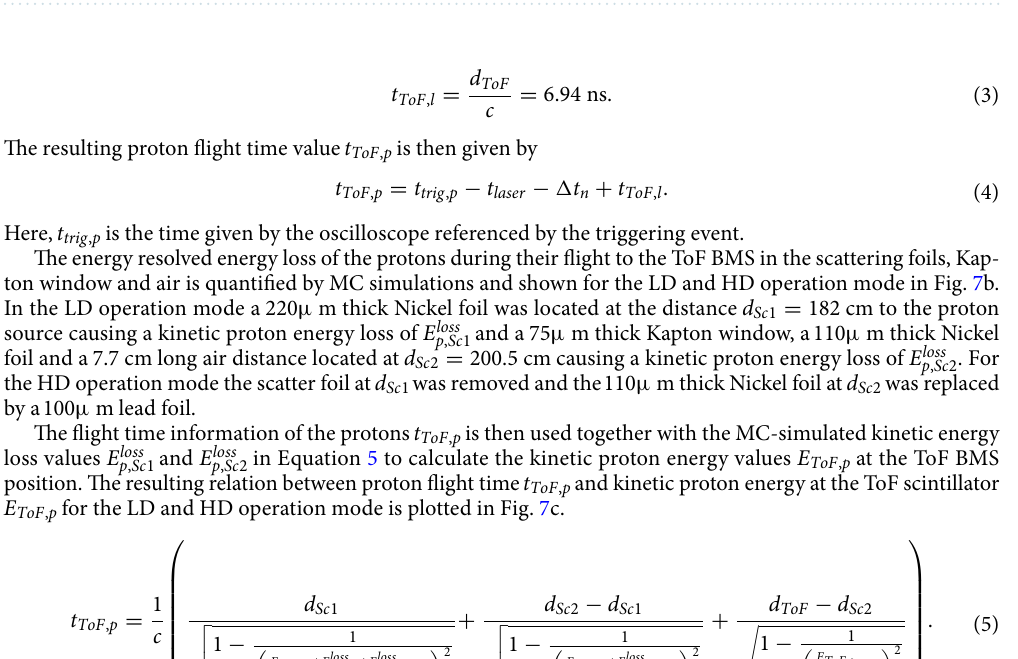
Table 1. Atomic composition of EBT3 film layers from the company GAFchromic 43